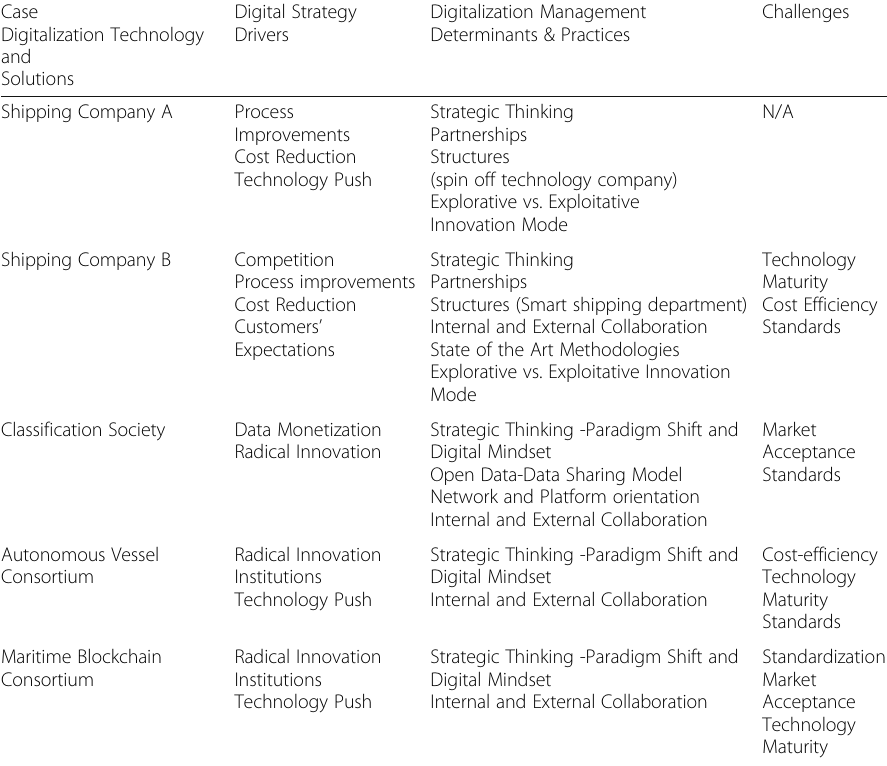
Table 4 Study Findings Case Digitalization